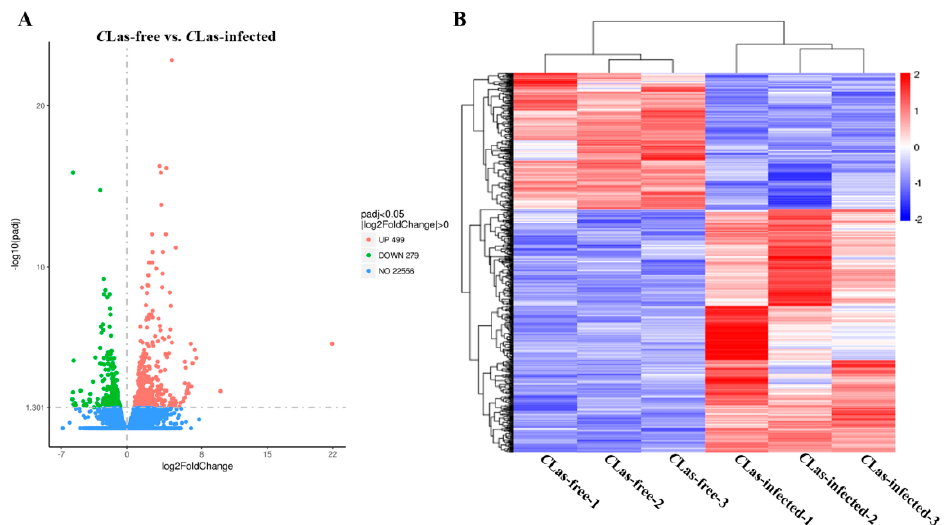
Figure 2. The identification and hierarchical cluster analysis of differentially expressed genes. ( A ) A scatter diagram for each gene. The blue, red and green points represent no difference in expression, upregulated genes and downregulated genes, respectively. ( B ) Hierarchical clustering of differentially expressed genes (DEGs) between the C Las-free groups and C Las-infected groups. Columns indicate different samples. Rows represent different DEGs. Blue bands indicate a low expression level, and red bands indicate a high gene expression level.